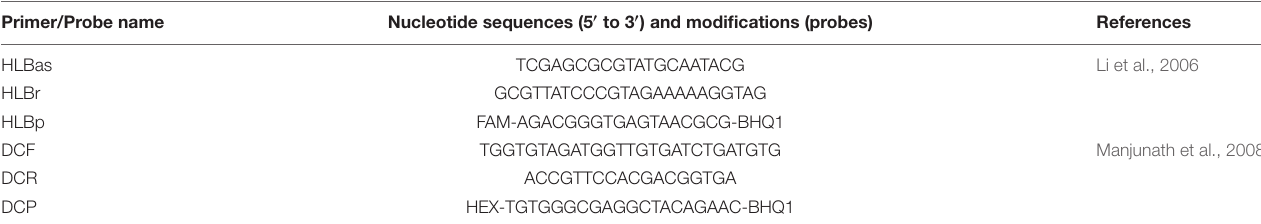
TABLE 1 | Primers and probes to detect 16SrDNA from “ Candidatus Liberibacter asiaticus” and wingless gene from Diaphorina citri using qPCR. Primer/Probe